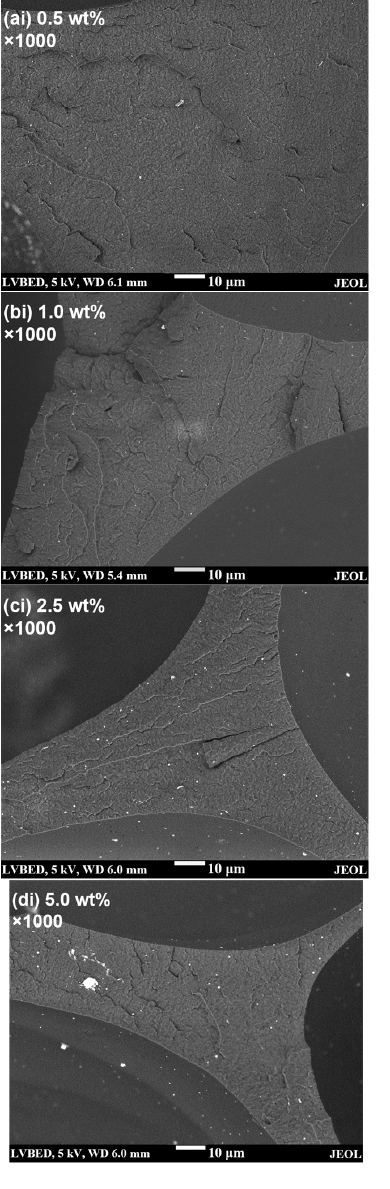
Figure 2. Typical SEM images showing the fractured cross-section surfaces of PP/lignin foams with ( a ) 0.5, ( b ) 1.0, ( c ) 2.5, and ( d ) 5.0 wt% of lignin at ( i ) low magnification and ( ii ) high magnification (also used for lignin particle size distribution analysis of diameter < 1 µm).